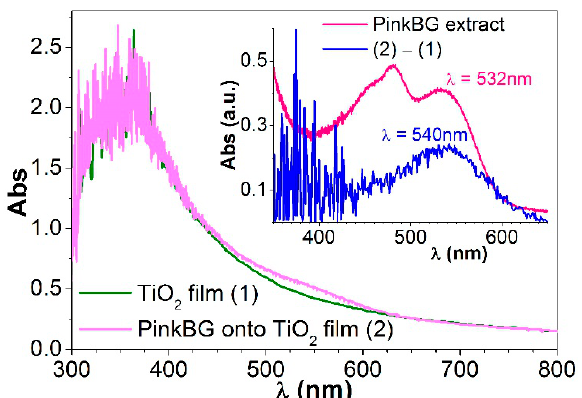
Figure 6. Absorption spectrum of TiO 2 film (green line 1) and pink bougainvillea extract adsorbed onto TiO 2 film (pink line 2). Inset: main peak of adsorbed dye onto TiO 2 film after removing film contribution (2-1, blue line) compared to pink bougainvillea extract solution (magenta line).